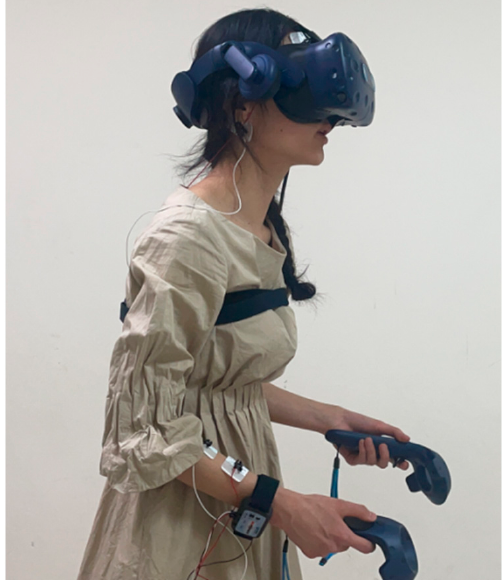
Figure 11. Experiment scene schematic 1.